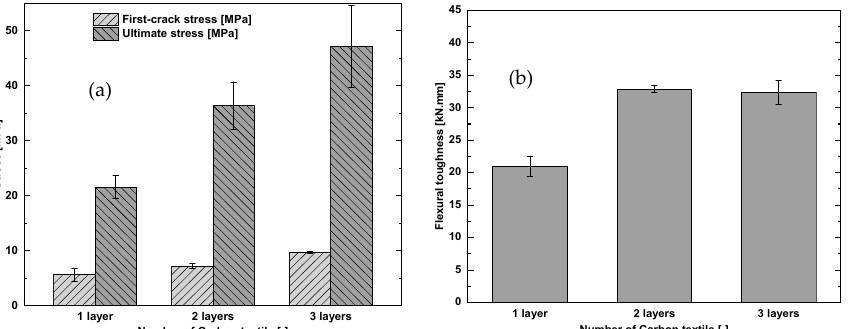
Figure 10. The mechanical strength of one to three textile layer reinforced specimens without BF addition: ( a ) flexural stress; ( b ) flexural toughness.